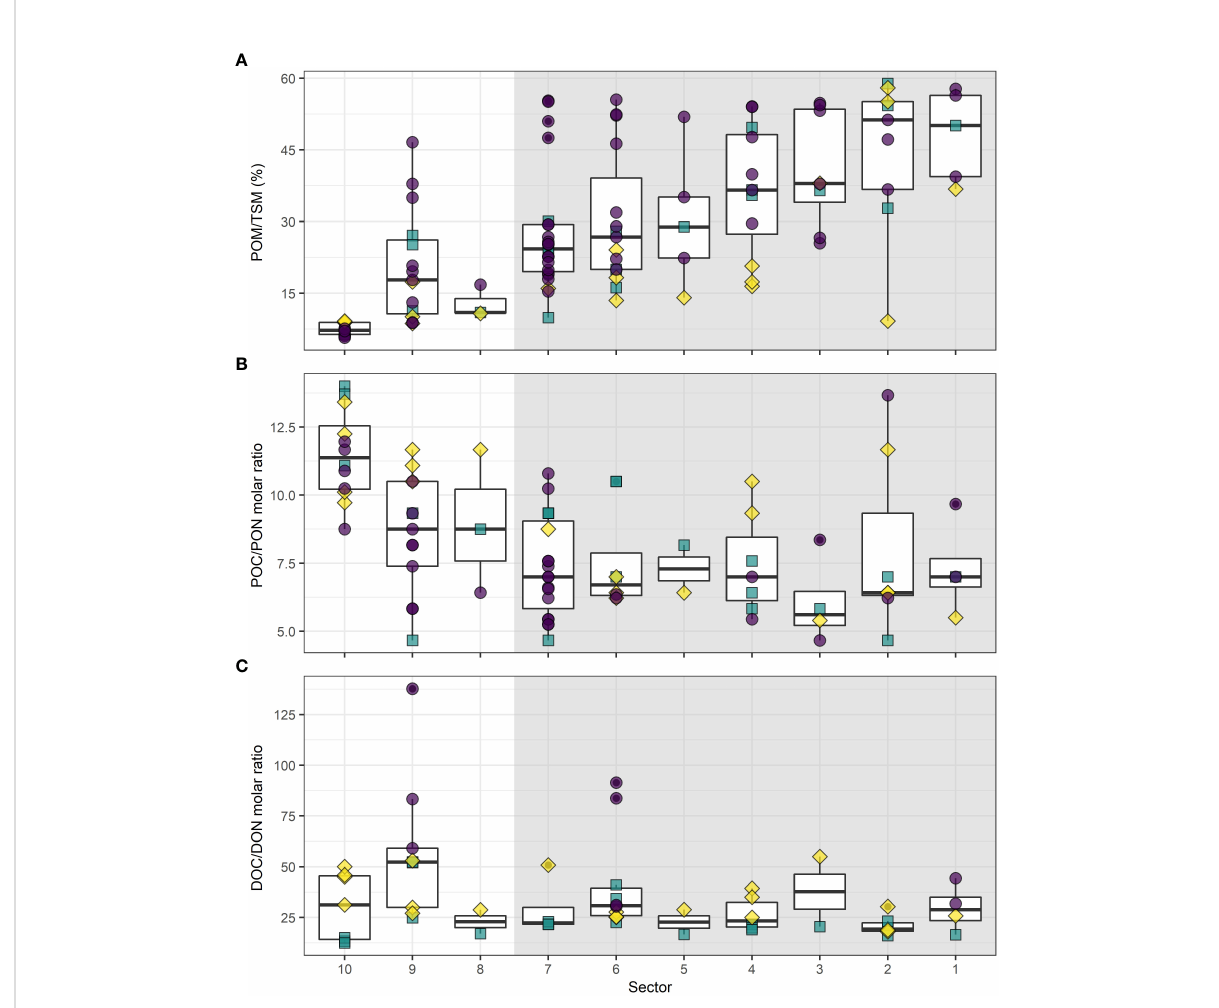
FIGURE 6 Boxplot of (A) POM/TSM (%), (B) POC/PON (molar), (C) DOC/DON (molar) ratios of the surface water of the USLE (white background) and LSLE (grey background). For each box plot, the median is represented by the bolded line while the 25 th and 75 th percentile are represented by the bottom and top of the box, respectively. The whiskers represent the minimum and maximum values (1.5 × interquartile range). Purple circles = August 2016, turquoise squares = October 2016, yellow diamonds = May